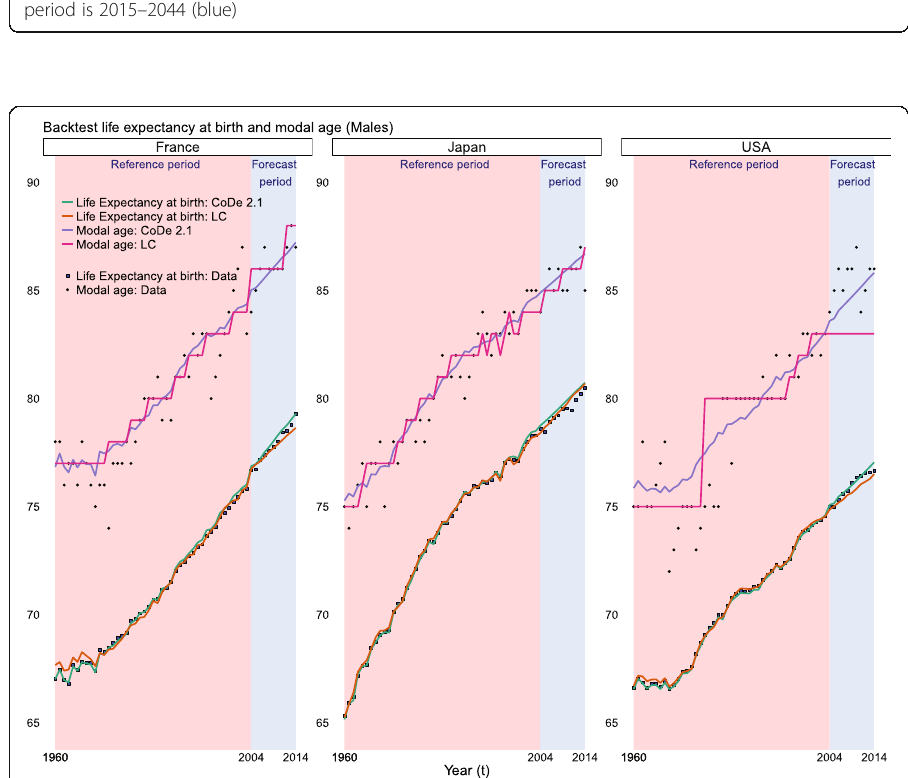
Fig. 11 Estimation and in-sample projections of life expectancy at birth and the modal age of males using the CoDe 2.1 model and the LC model. The reference period is 1960 – 2004 (pink); the projection period is 2005 – 2014